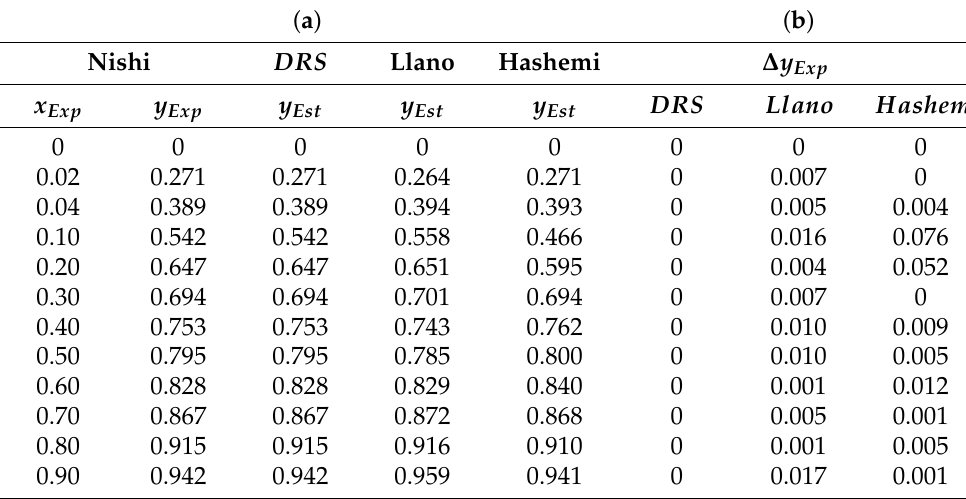
Table 3. Comparison between the data calculated by the DRS versus the experimental data of Nishi and those estimated by Llano and Hashemi: ( a ) vapor phase; ( b ) differences between the vapor phase data; ( c ) temperatures; ( d ) difference between the temperature